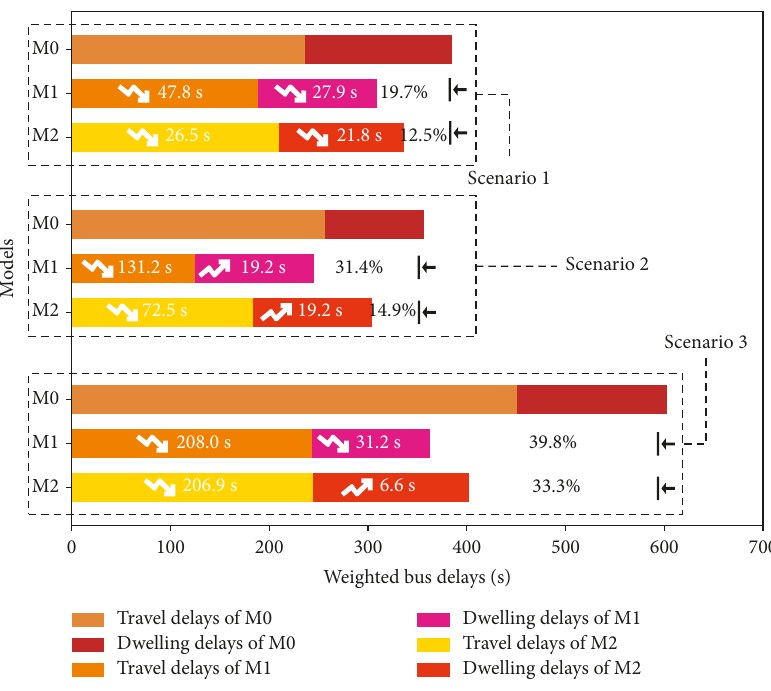
Figure 6: Weighted bus